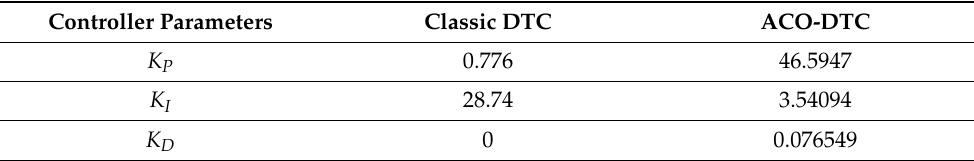
Table 3. PID controller Parameters under classical DTC and